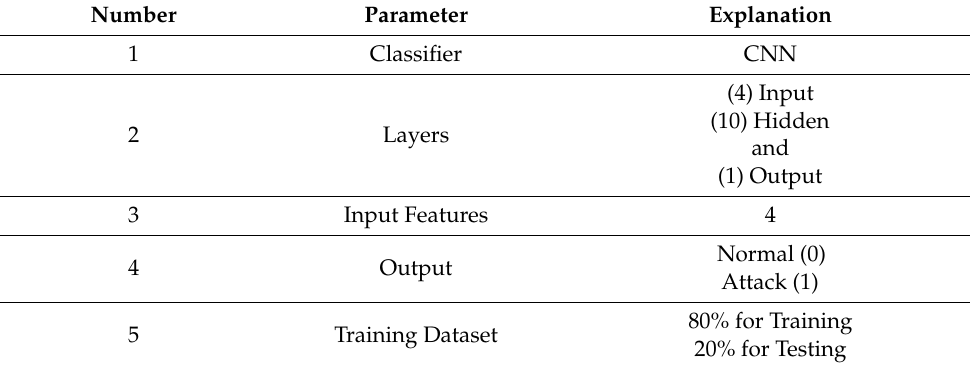
Table 2. CNN classifier training parameters for Bot-IoT.